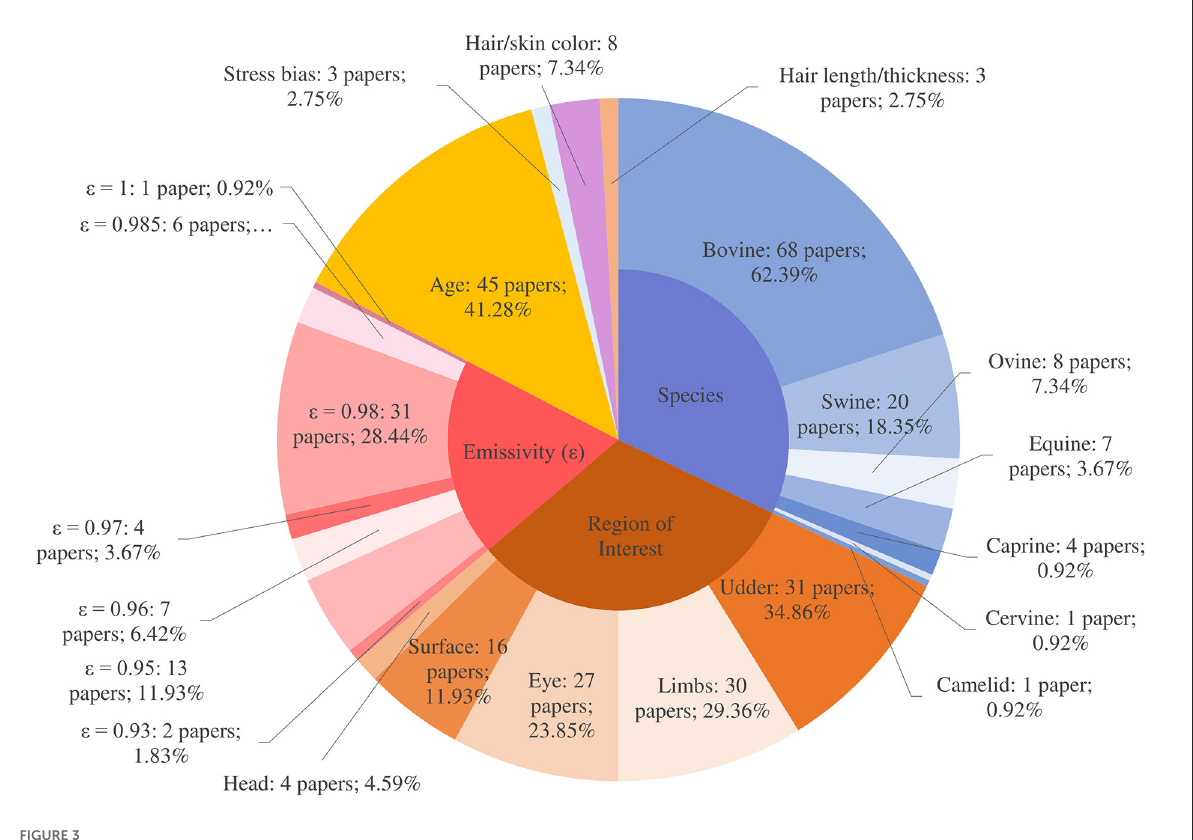
FIGURE3 Animal-related parameter